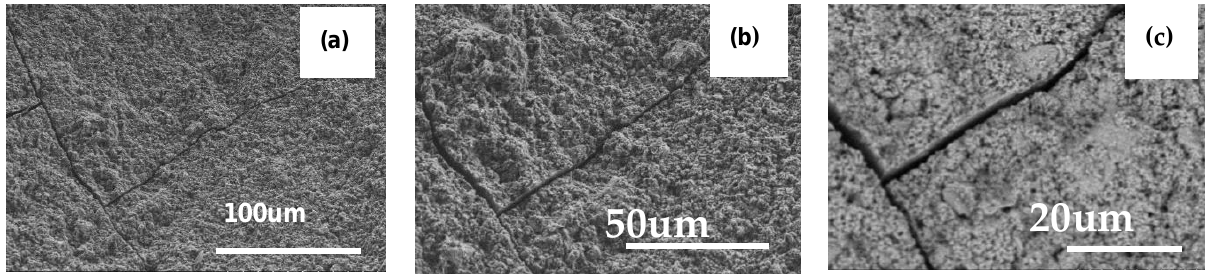
Figure 2. SEM images of the HAOPs layer ( a ) 100 μ m, ( b ) 50 μ m and ( c ) 20 μ m.